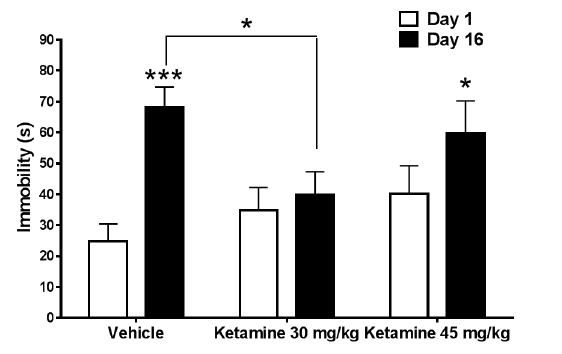
Figure 2 - Ketamine 30 mg/kg/day i.p. for 14 days decreases the immobility time of animals on the forced swimming test. Results are expressed as mean ± S.E.M (n = 8-12). *** p < 0.001, * p < 0.05 on the post-hoc test.